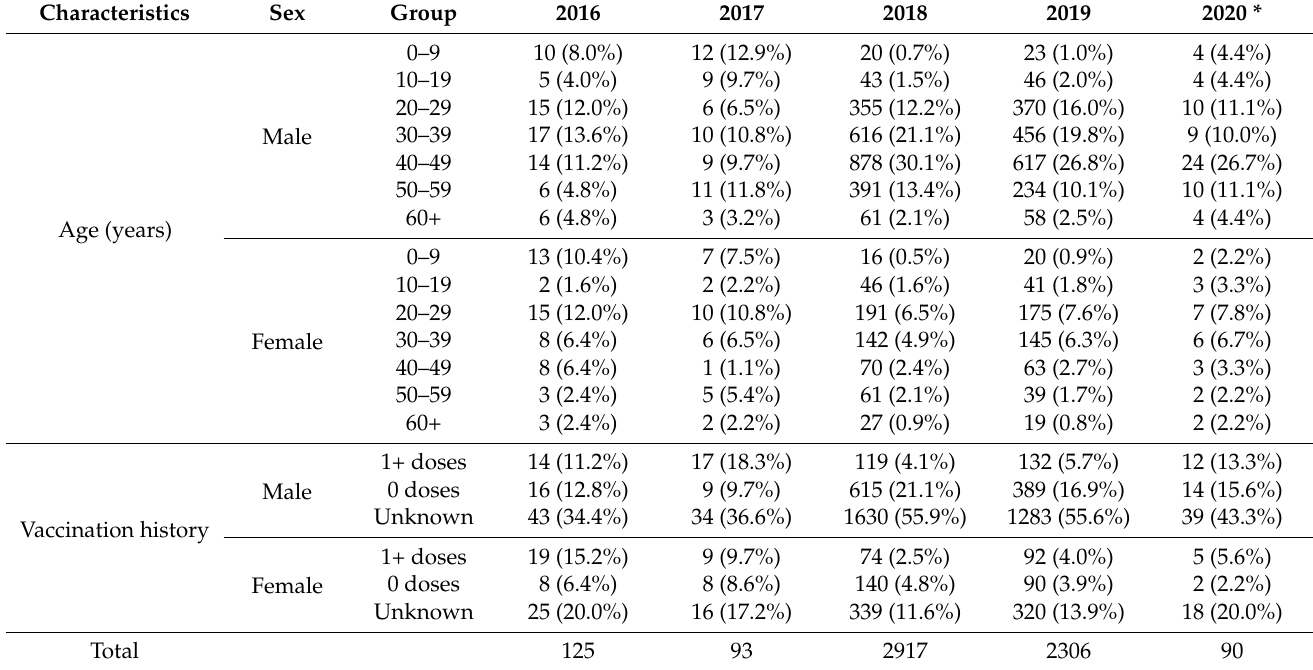
Table 6. Reported rubella cases, aggregated by age and vaccination history [16,18,19].